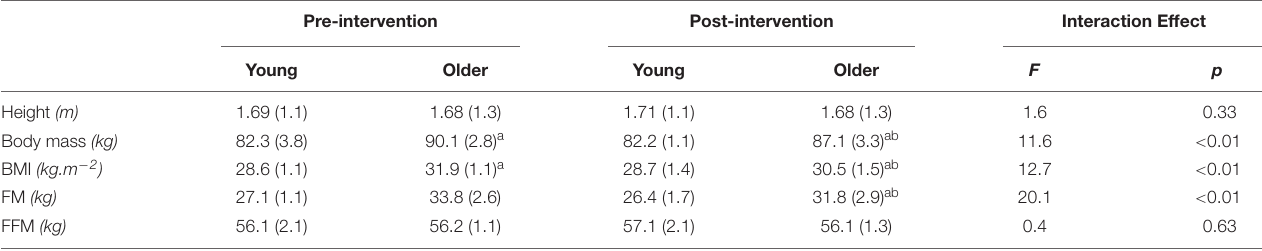
TABLE 1 | Results on anthropometric data before (pre-intervention) and after (post-intervention) the supramaximal cycling exercise (SCE) intervention for both young and older groups. Pre-intervention Post-intervention Interaction Effect Young Older